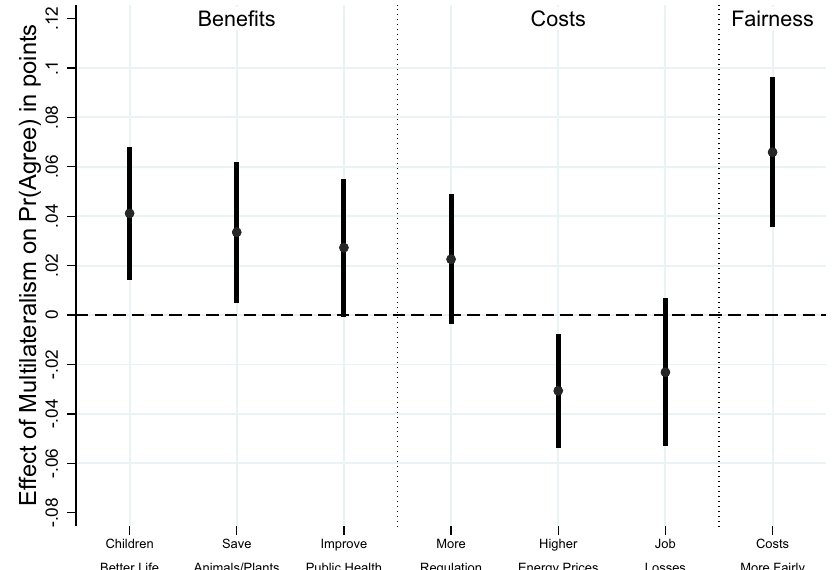
Fig. 2 | The causal effects of multilateralism on sustainability beliefs: bene fi ts, costs, and fairness of climate action in France, Germany, and the United Kingdom ( N =6000). This plot reports coef fi cients from linear regressions of statement approvalonabinary indicator thatisone ifclimateactionismultilateral and is zero if climate action is unilateral. Error bars indicate 95% con fi dence